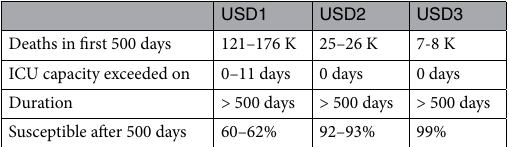
Table 6. Results for the uniform social distancing scenarios.